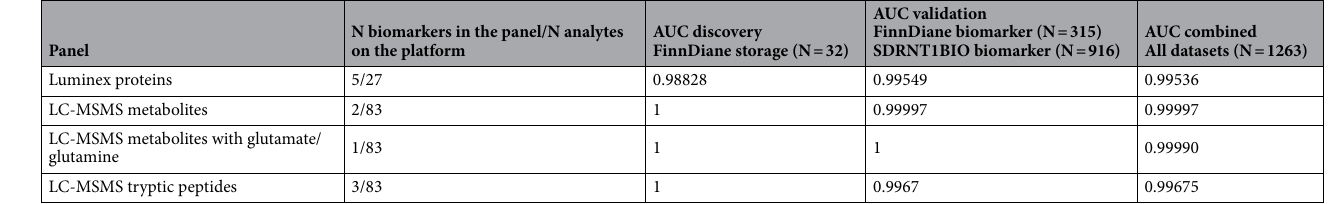
Table 5. Performance of the LASSO-penalised biomarker panels in predicting the storage temperature in the FinnDiane discovery dataset, FinnDiane validation and SDRNT1BIO validation datasets and all datasets